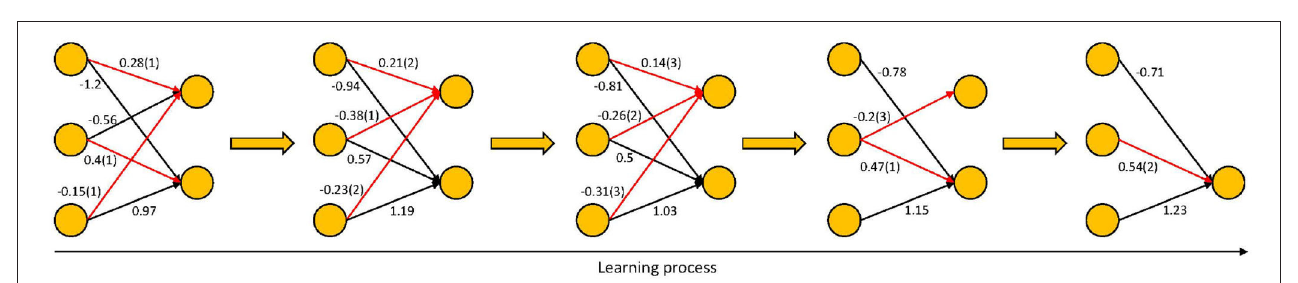
FIGURE 1 | The synaptic pruning strategy of BSP algorithm.